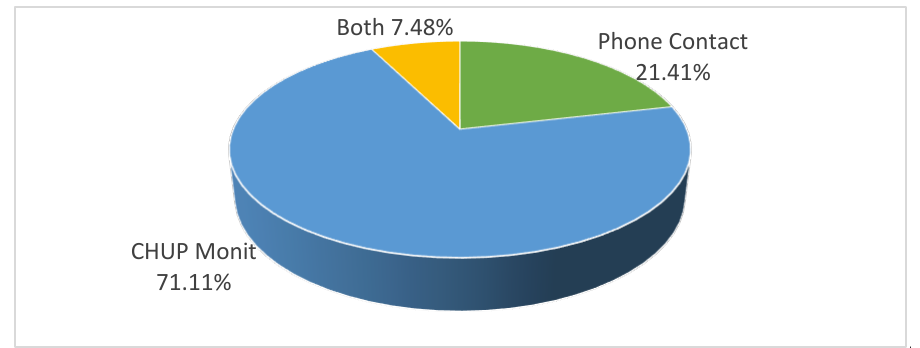
Figure 9. Distribution of interaction by channels.